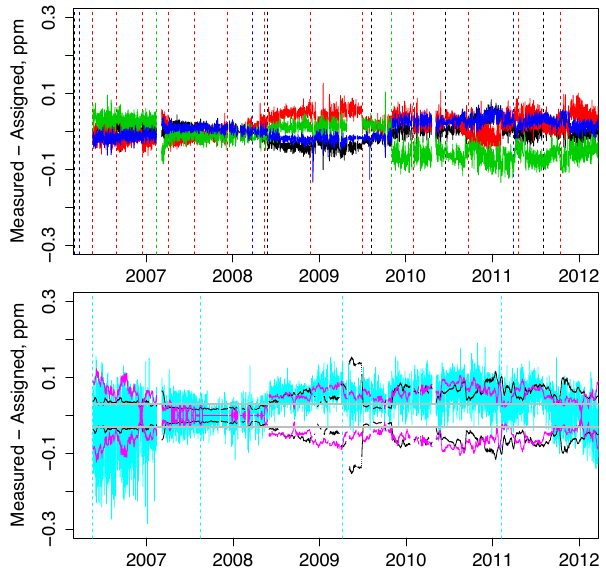
Fig. 8. Standard gas residuals (i.e., assigned minus measured χ CO values) for (a) CO2C1 (black), CO2C2 (red), CO2C3 (green), CO2C4 (blue) calibration and (b) CO2TGT (cyan) standards at WKT for the period 2006–2011. Dashed vertical lines in both panels correspond to dates when standards were replaced. The black and magenta curves in (b) correspond to the 10-day running means of u M and u TGT , respectively, where u M corresponds to the larger of the values produced by Eq. (9a) and (9b). From April to July 2009, u M is higher than normal, because during that time no CO2C3 cali- brations were run, so z in Eq. (9) corresponds to 1 degree of freedom instead of 2 during that